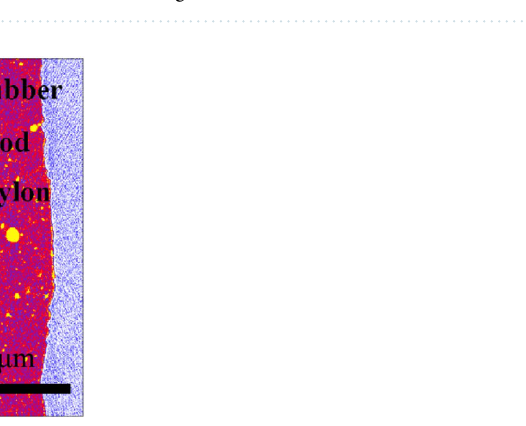
Figure 21. Area selection from the nylon-rubber CT images.